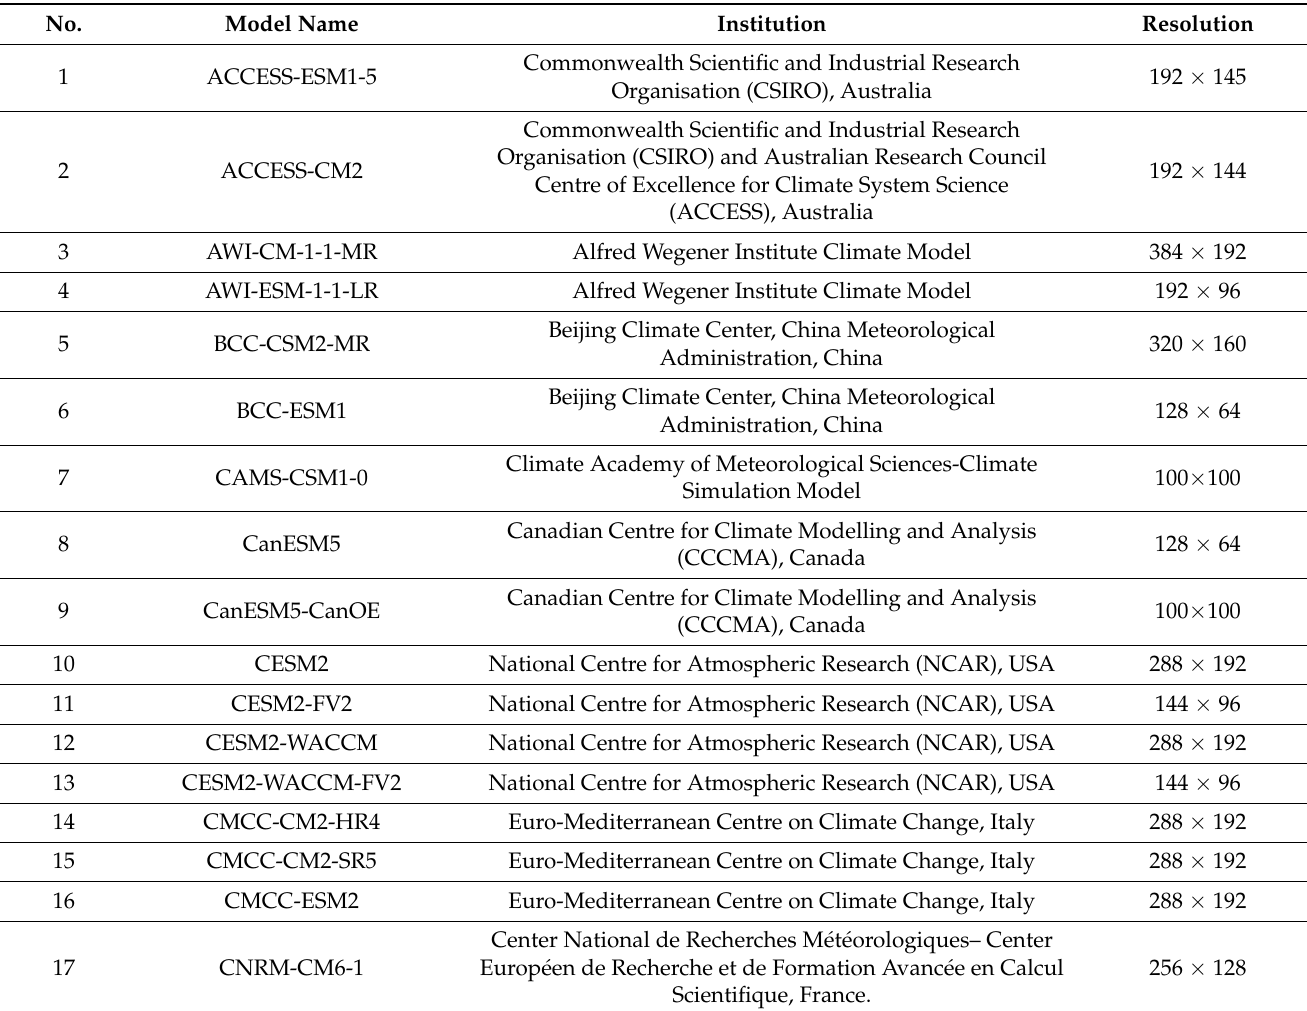
Table 1. The information on the CMIP6 Global Climate Models (GCM) used in this